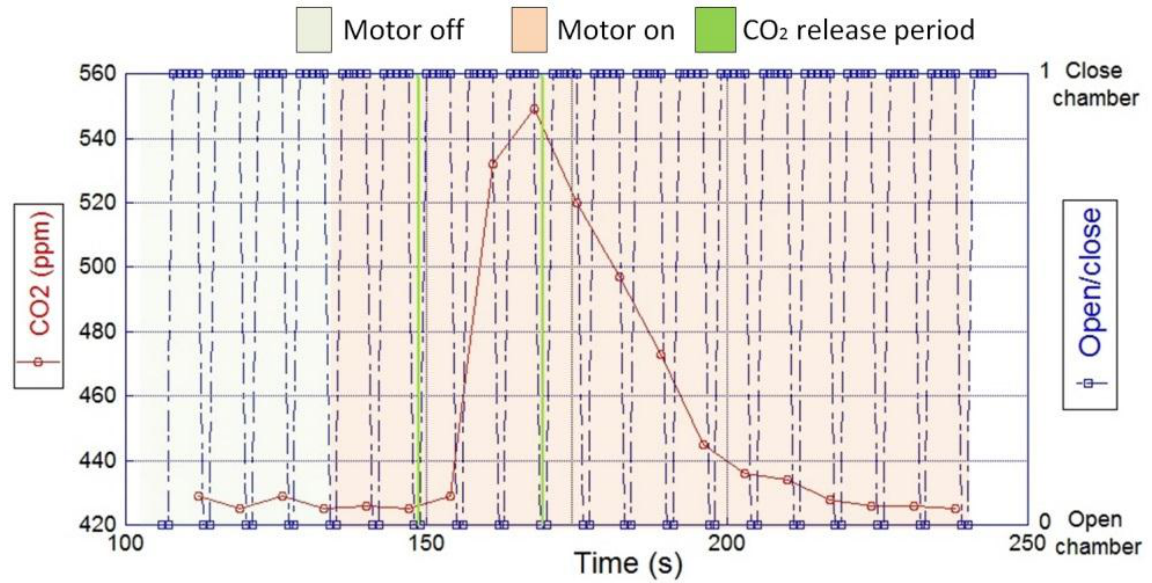
Figure 9. Bench testing of the CO 2 gas sensing system integrated in the aircraft